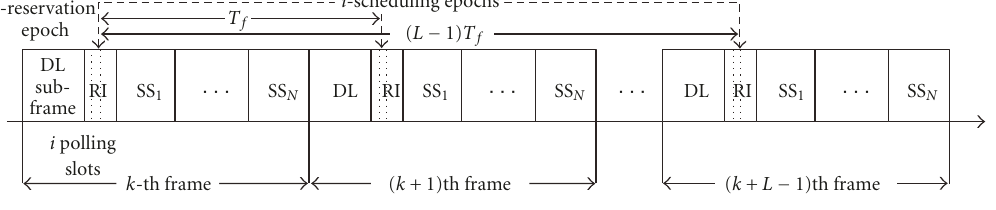
Figure 6: Characteristic epochs of uplink scheduling.